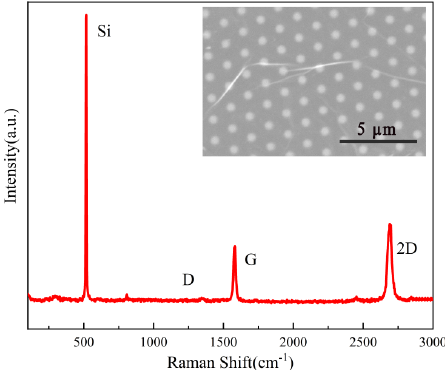
Figure 3. Raman spectrum of the graphene/Si NTCAs; the inset shows an SEM image of the gra- phene layer on the Si NTCAs. In order to characterize the light trapping properties of the Si NTCAs, a finite differ- ential time domain (FDTD) method-based simulation was conducted. The reflections of planar silicon and silicon nanopillars were also studied for comparison. The simulation model is shown in Figure 4. Silicon was chosen as the simulation material and a cuboid with a length of 1.5 µm, a width of 1 µm, and a height of 5 µm was established as the planar silicon model (Figure 4a). The height and diameter of the pillars in the nanopillar